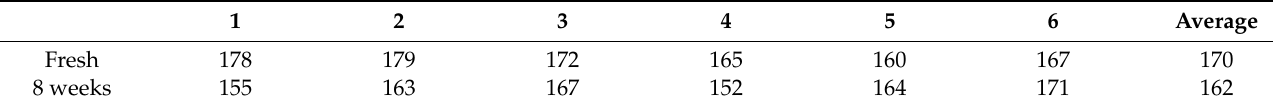
Figure 14. Load-displacement curves of the FSW specimen: ( a ) Uncorroded; ( b ) corroded after eight weeks. Table 5. Summary of the peak strength. (unit: N/mm). Table 5. Summary of the peak strength. (unit: N/mm).